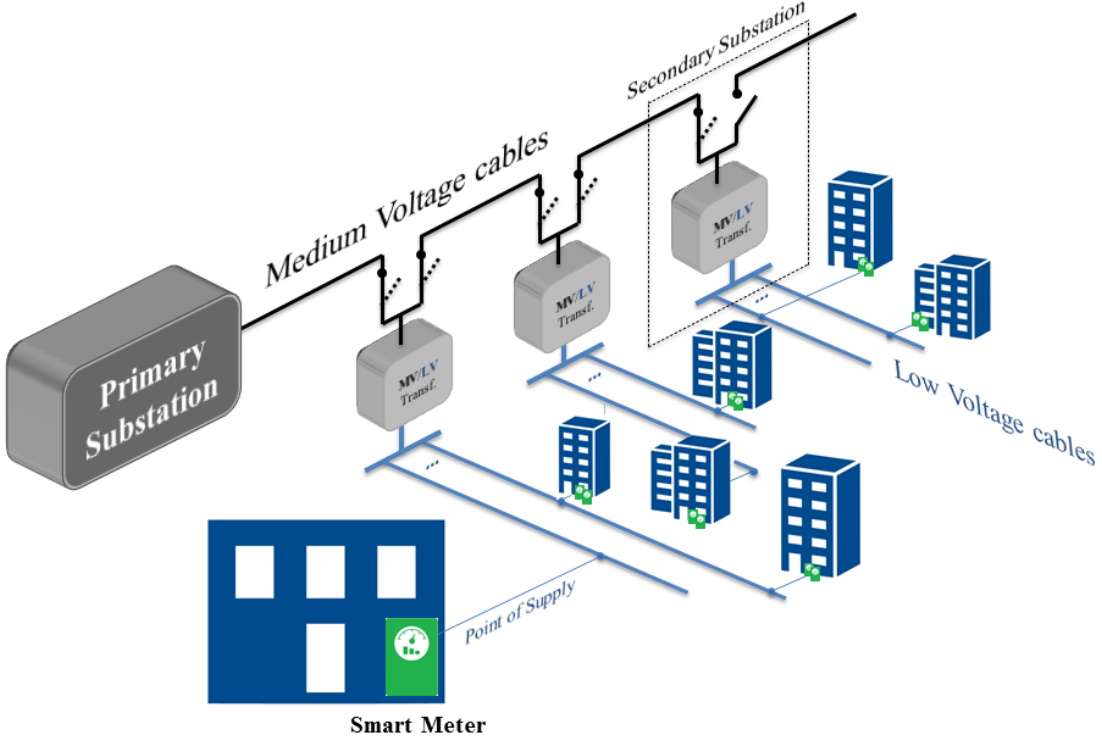
Figure 1. Electricity distribution